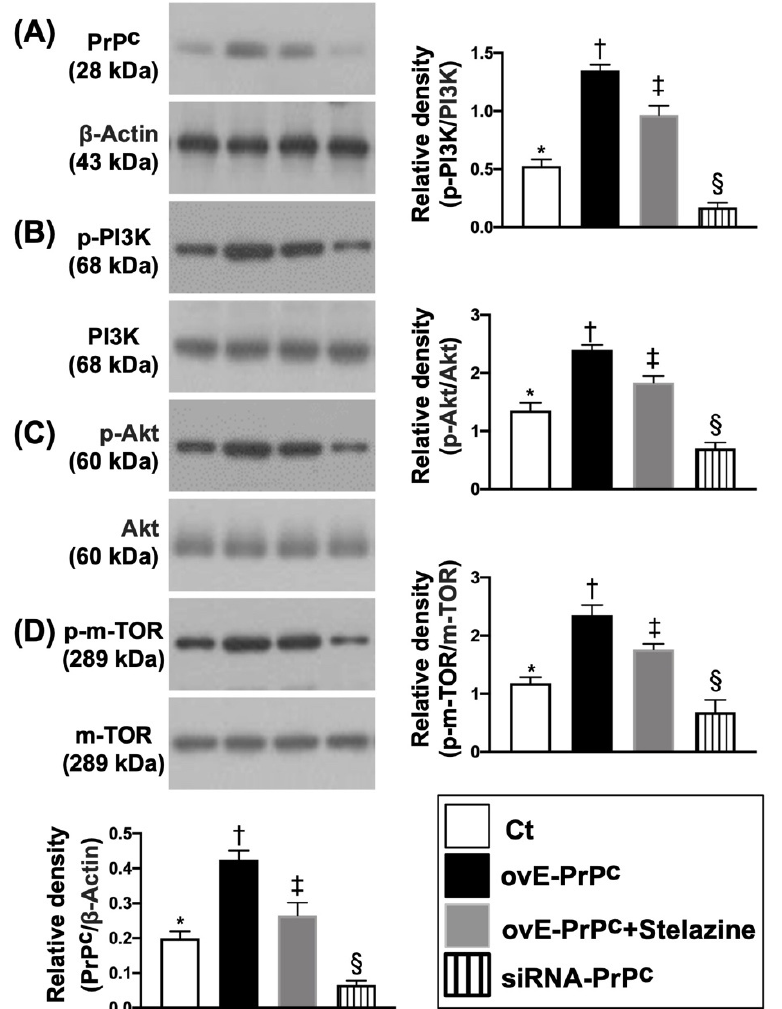
Figure 2. PrP C regulated the cell-stress signaling pathway in H9C2 cells. ( A ) Protein expression of PrP C , * vs. other groups with different symbols (†, ‡, §), p < 0.0001. ( B ) Protein expression of phosphorylated (p)-PI3K, * vs. other groups with different symbols (†, ‡, §), p < 0.0001. ( C ) Protein expression of p-Akt, * vs. other groups with different symbols (†, ‡, §), p < 0.0001. ( D ) Protein expression of p-m-TOR), * vs. other groups with different symbols (†, ‡, §), p < 0.0001. All statistical analyses were performed by one-way ANOVA, followed by Bonferroni multiple comparison post-hoc test (n = 3 for each group). Symbols (*, †, ‡, §) indicate significance (at 0.05 level). Ct = control group (i.e., H9C2 cells only); ovE-PrP C = overexpression of PrP C in H9C2 cells; siRNA-PrP C = siRNA knockdown PrP C in H9C2 cells; PI3K = Phosphoinositide 3-kinase; m-TOR = mammalian target of rapamycin (m-TOR); RAC(Rho family)-alpha serine/threonine-protein